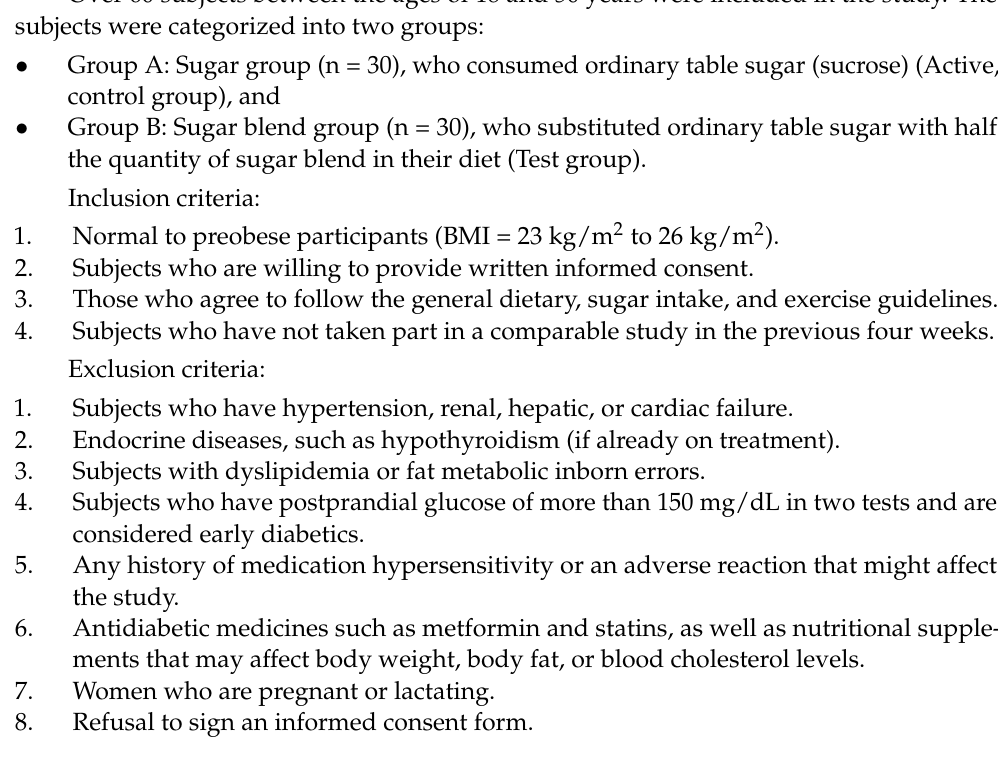
table sugar with sugar blend in the diet while maintaining a healthy lifestyle in healthy adults with a BMI of 23–26 kg/m 2